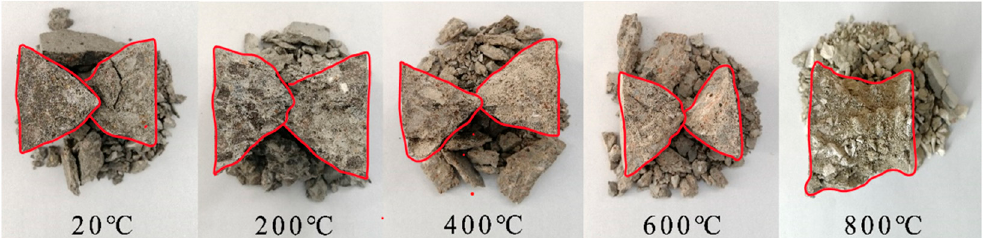
Figure 11. Typical failure mode of concrete in a high-temperature uniaxial static compression test. As can be seen from Figure 12: